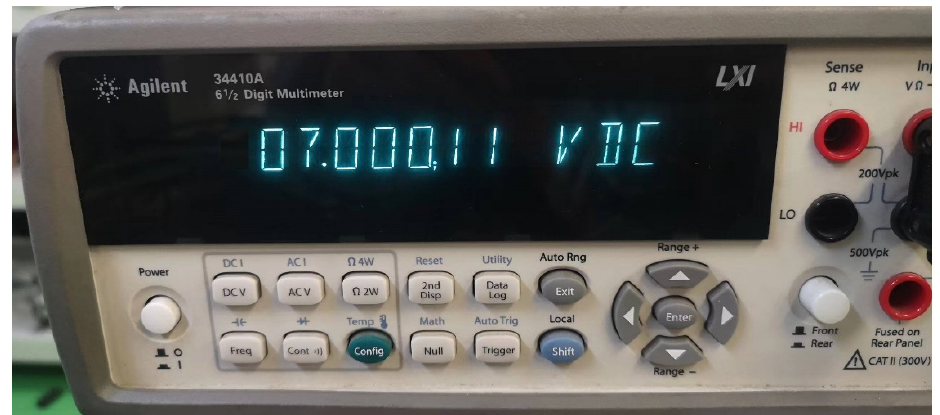
Figure 11. LDO input voltage ripple ( 𝑉 (cid:3014)(cid:3016)(cid:3020)(cid:2879)(cid:3005) ) and test value of the output high voltage ( 𝑉 (cid:3042) ).